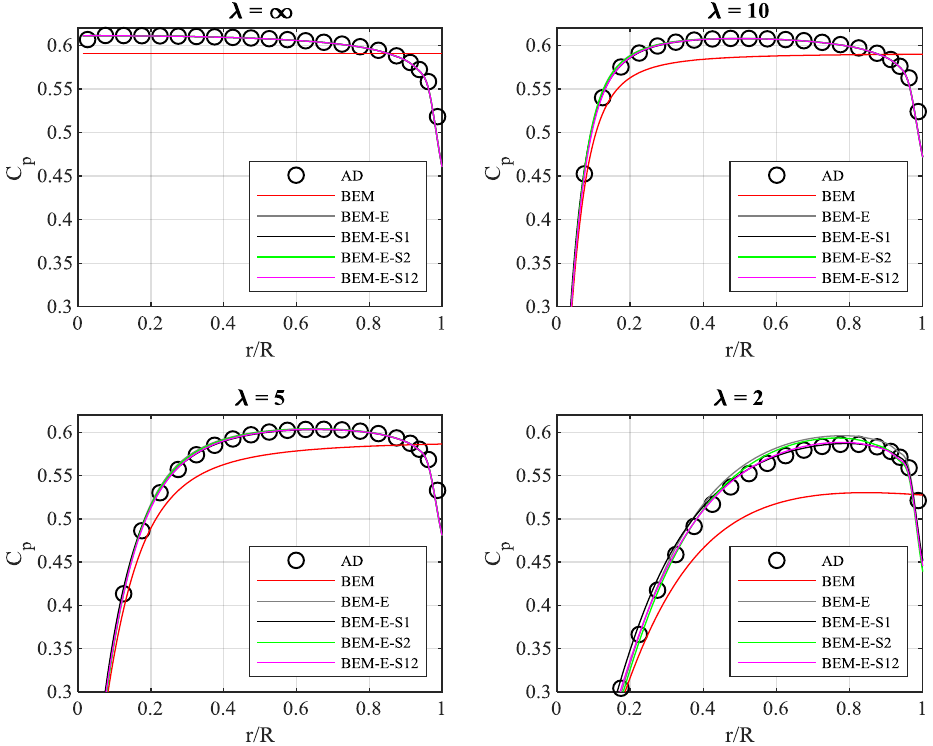
Figure 11. Power coefficient comparisons at optimal loading for the AD and BEM methods.